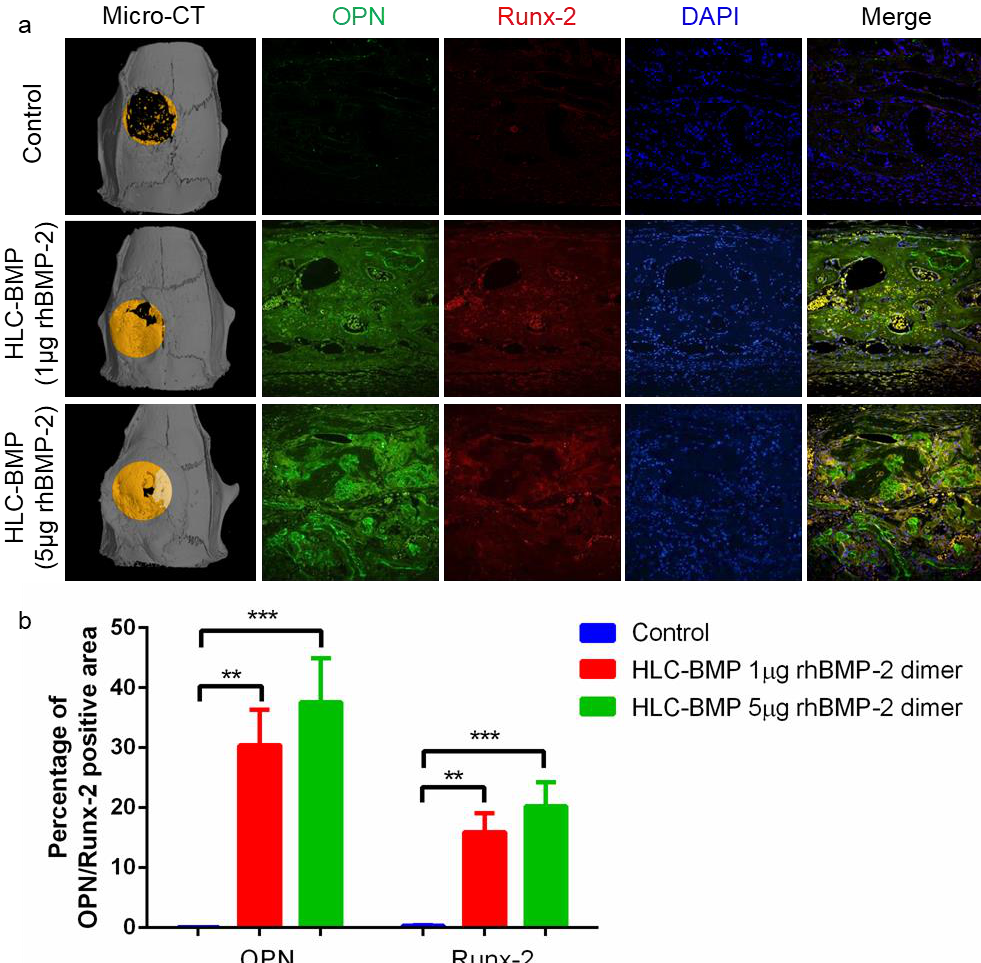
Figure 8. Micro-CT and fluorescent microscopy analysis of the rat cranial defect repair using different doses of BMP-2 at 8 weeks after implantation. ( a ) Representative micro-CT images and immunofluorescent staining of implants (Control, HLC-BMP sponge loading with 1 µg and 5 µg rhBMP-2 dimer, respectively) 8 weeks after implantation. Nuclei were stained blue with DAPI, OPN was stained green, and Runx-2 was stained red. ( b ) Quantitative estimation of OPN and Runx-2 expression in each group ( ** p < 0.01, *** p < 0.001, n = 18).